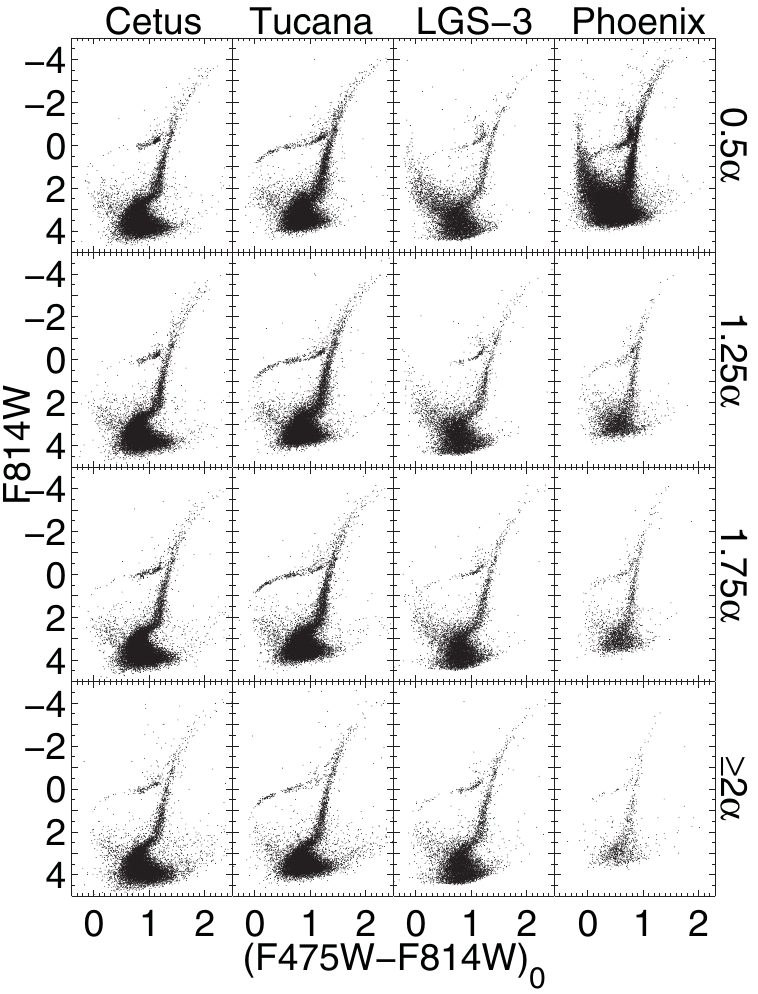
Figure 1. Color-magnitude diagrams of the galaxies as a function of the distance to the center. Each row corresponds to a region in which the observed fields were divided. The mean distance to the center is marked in scale length units on the right side of the